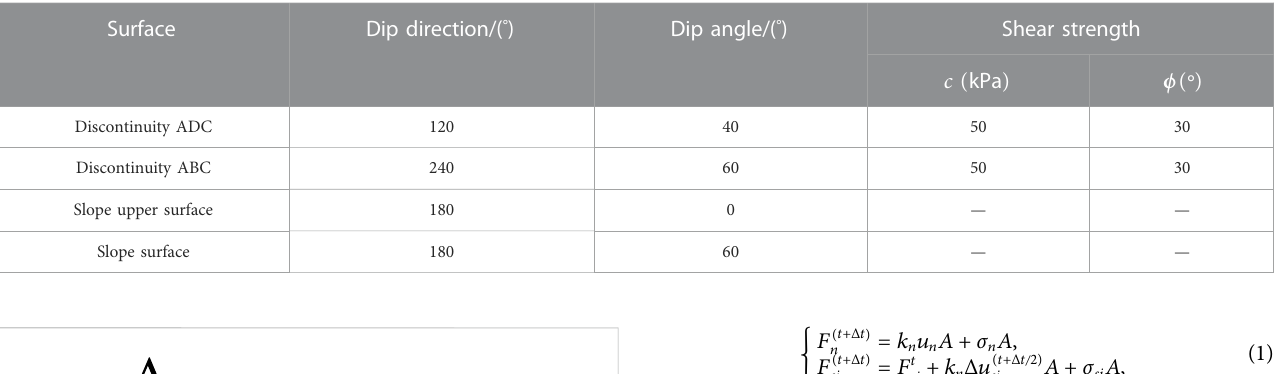
TABLE 2 Geometrical and material parameters of example 2.